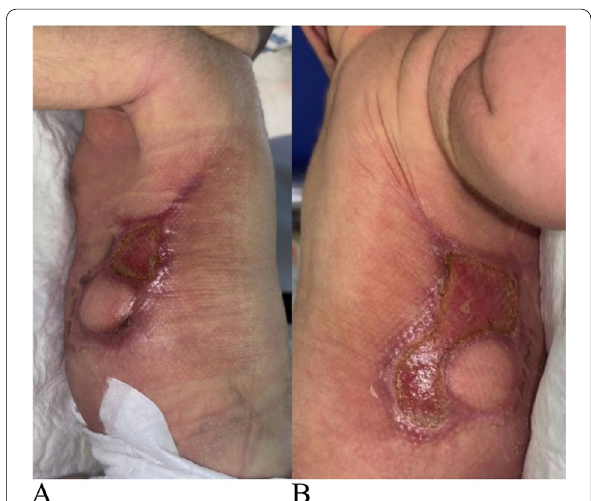
Fig. 1 Patient 1. Skin defects located on the posterior aspect of both thoraco-abdominal flanks (8 days of life). A Left side. B Right side